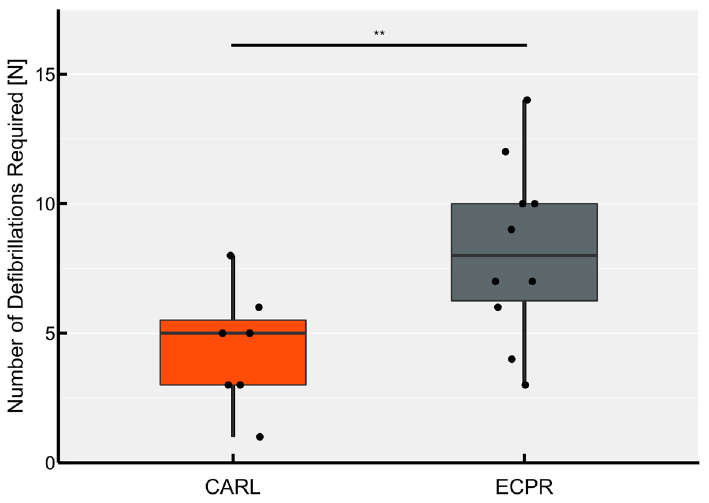
Figure 5. Number of shocks (200 J) delivered. Each point represents the number of electric defibrillations required per animal for sustained rhythm conversion to sinus rhythm (** p < 0.01).